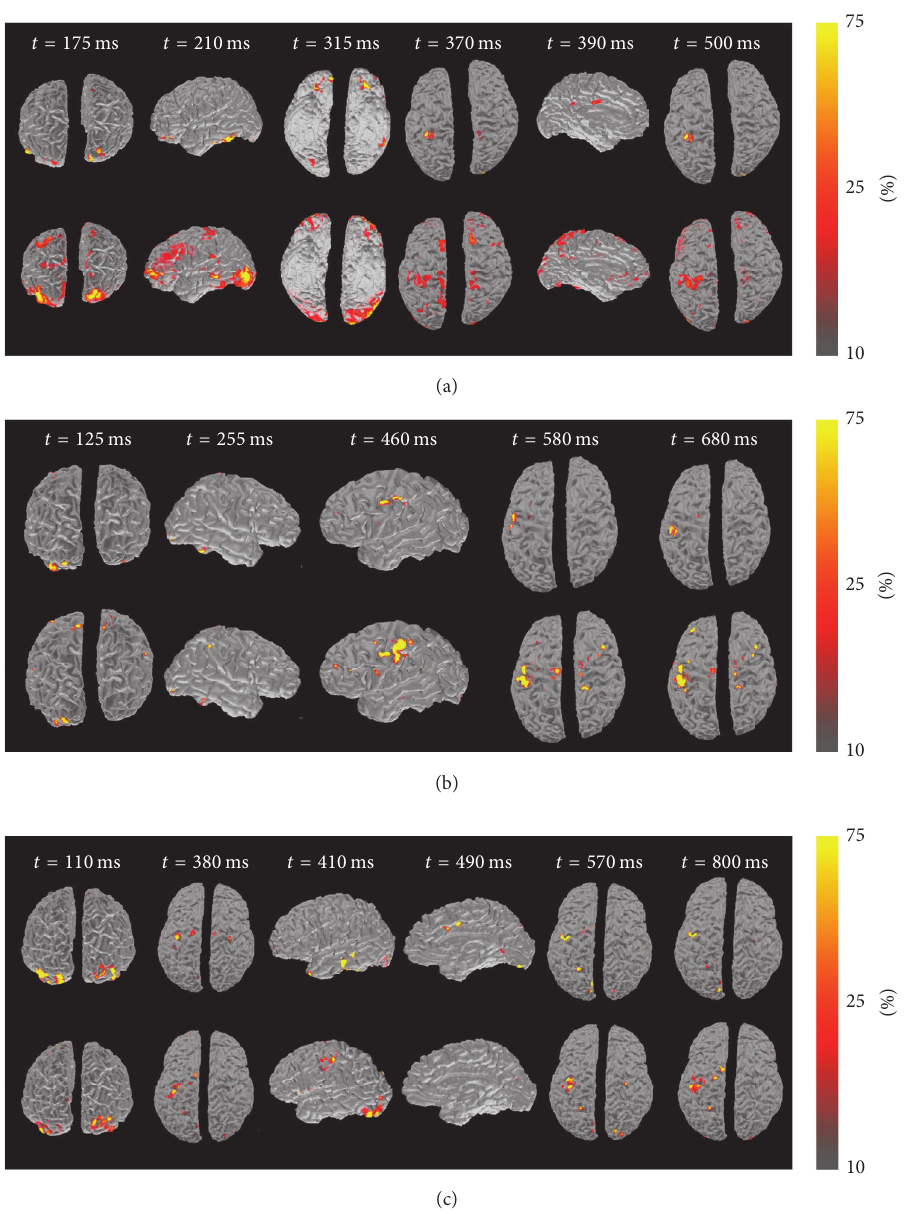
Figure 7: Transition period source imaging results for subjects #1, 2, and 3 in (a), (b), and (c), respectively. In each subfigure, top panel representssourceimagingresultsusingspatiotemporalfMRIconstrainedmethod,whilebottompanelshowstime-invariantfMRIconstrained method. Results highlight cortical activity at different time instances during the period of time transitioning between a visual input to subject’s response via motor output. Time stamps shown are with respect to the visual stimulus onset timing (at 𝑡 = 0 ms). Source activity shown is color coded as a percentage of its